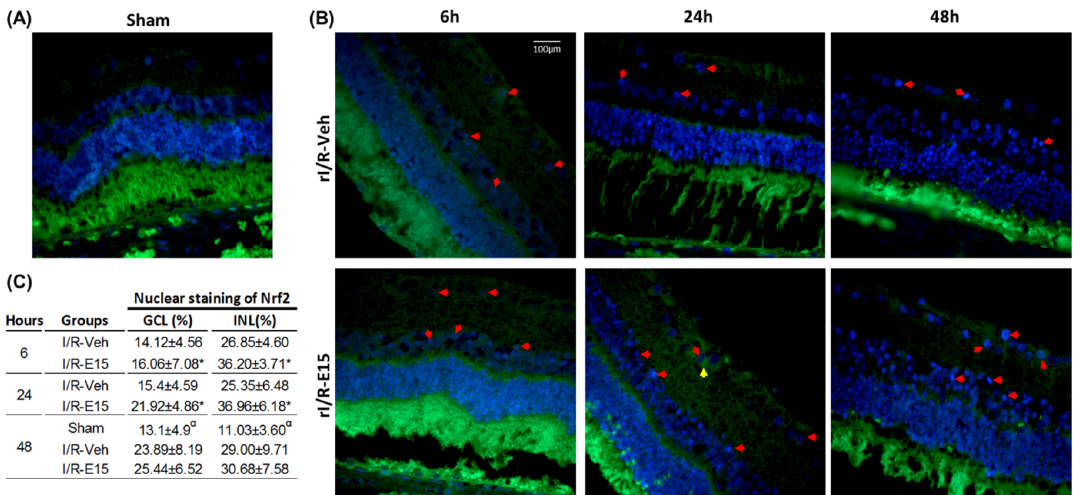
Figure 5. The antioxidant e ff ect of E15 related to nuclear staining of nuclear factor E2-related factor 2 (Nrf2). The antioxidant e ff ect was determined by nuclear immunostaining of Nrf2 after rI / R in the timeline. ( A ) Sham group at 48 h; ( B ) rI / R-veh at 6, 24, and 48 h after rI / R (upper panel), and rI / R-E15, at the same times (B; bottom panel). The nuclear (red arrows) and cytoplasmic (yellow arrows) Nrf2 staining and their nuclei stained with DAPI (blue) are showed. In ( C ), the table shows the nuclear percentage of NrF2 in INL and GCL (mean ± SD). * p < 0.05 compared to rI / R-veh and α p < 0.01 compared to rI / R-veh and rI / R-E15 groups, at 48 h. Scale bar = 100 µ